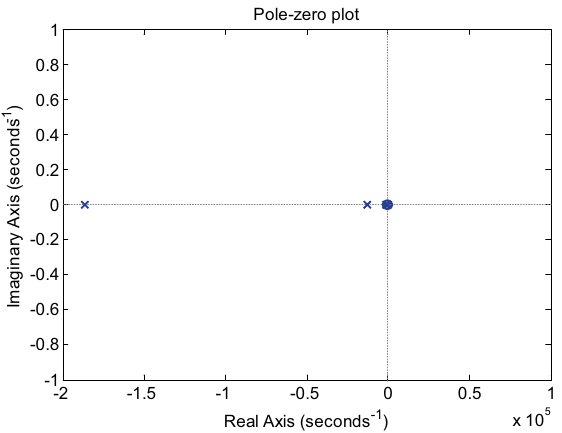
Figure 7. Pole-zero plot of the speed control system for the BLDCM based on